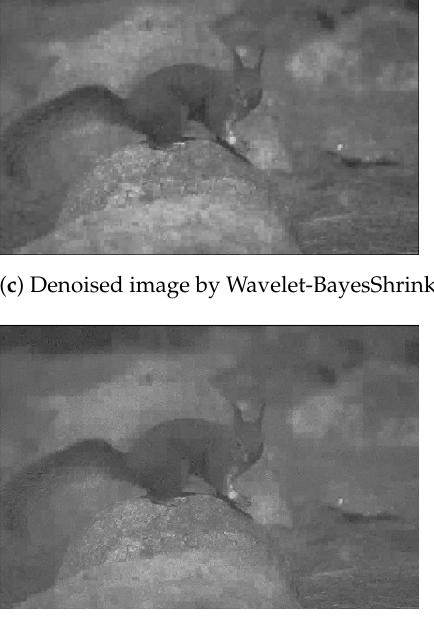
Figure 4. Denoised images using non-deep learning models and Proposed ensemble